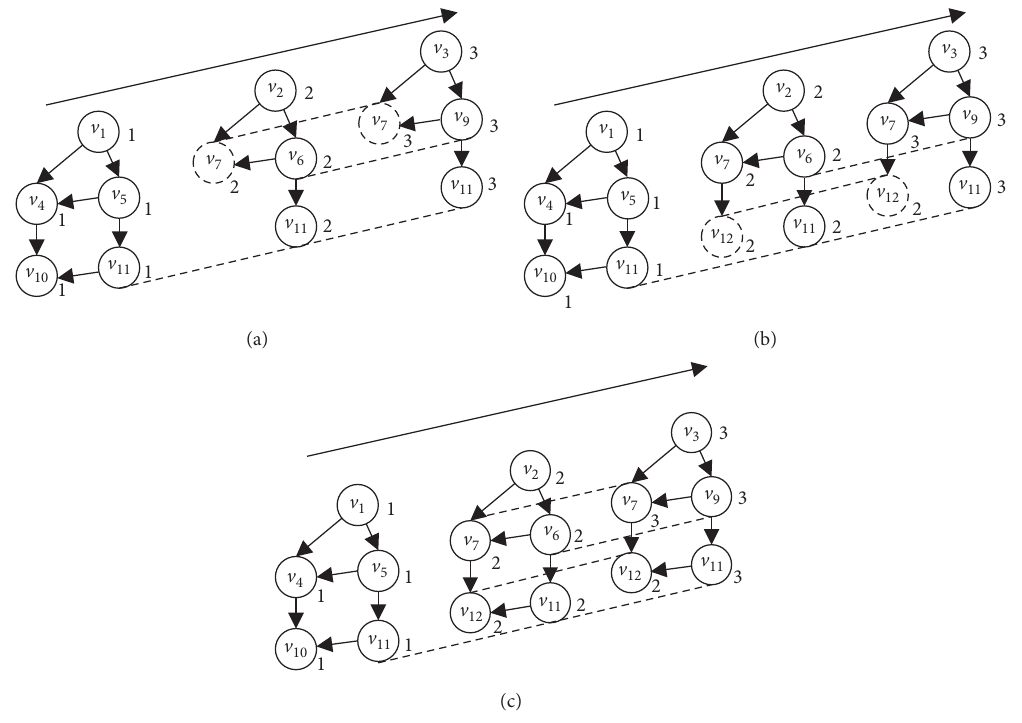
Figure 5: Sequential subdivision on flow graph views. (a) Sequential encoding on initial FG views. (b) Sequential encoding on FG views as insertion of ( v 7, v 12). (c) Sequential encoding on FG views as insertion of ( v 11, v